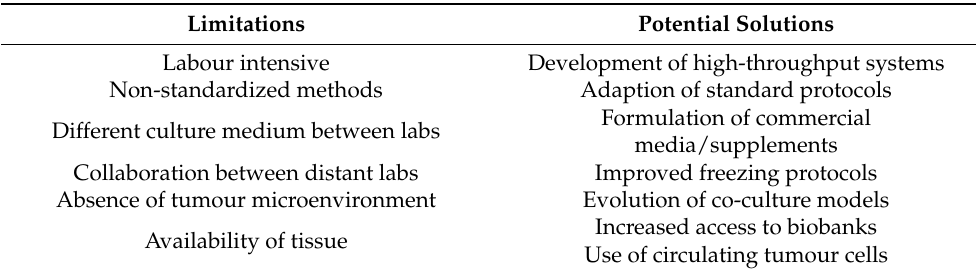
Table 2. Limitations of organoid establishment and potential solutions. The widespread use of organoids may be hindered in some laboratories by lack of expertise, protocols and availability of suitable tissue, and some simple solutions may be possible to overcome